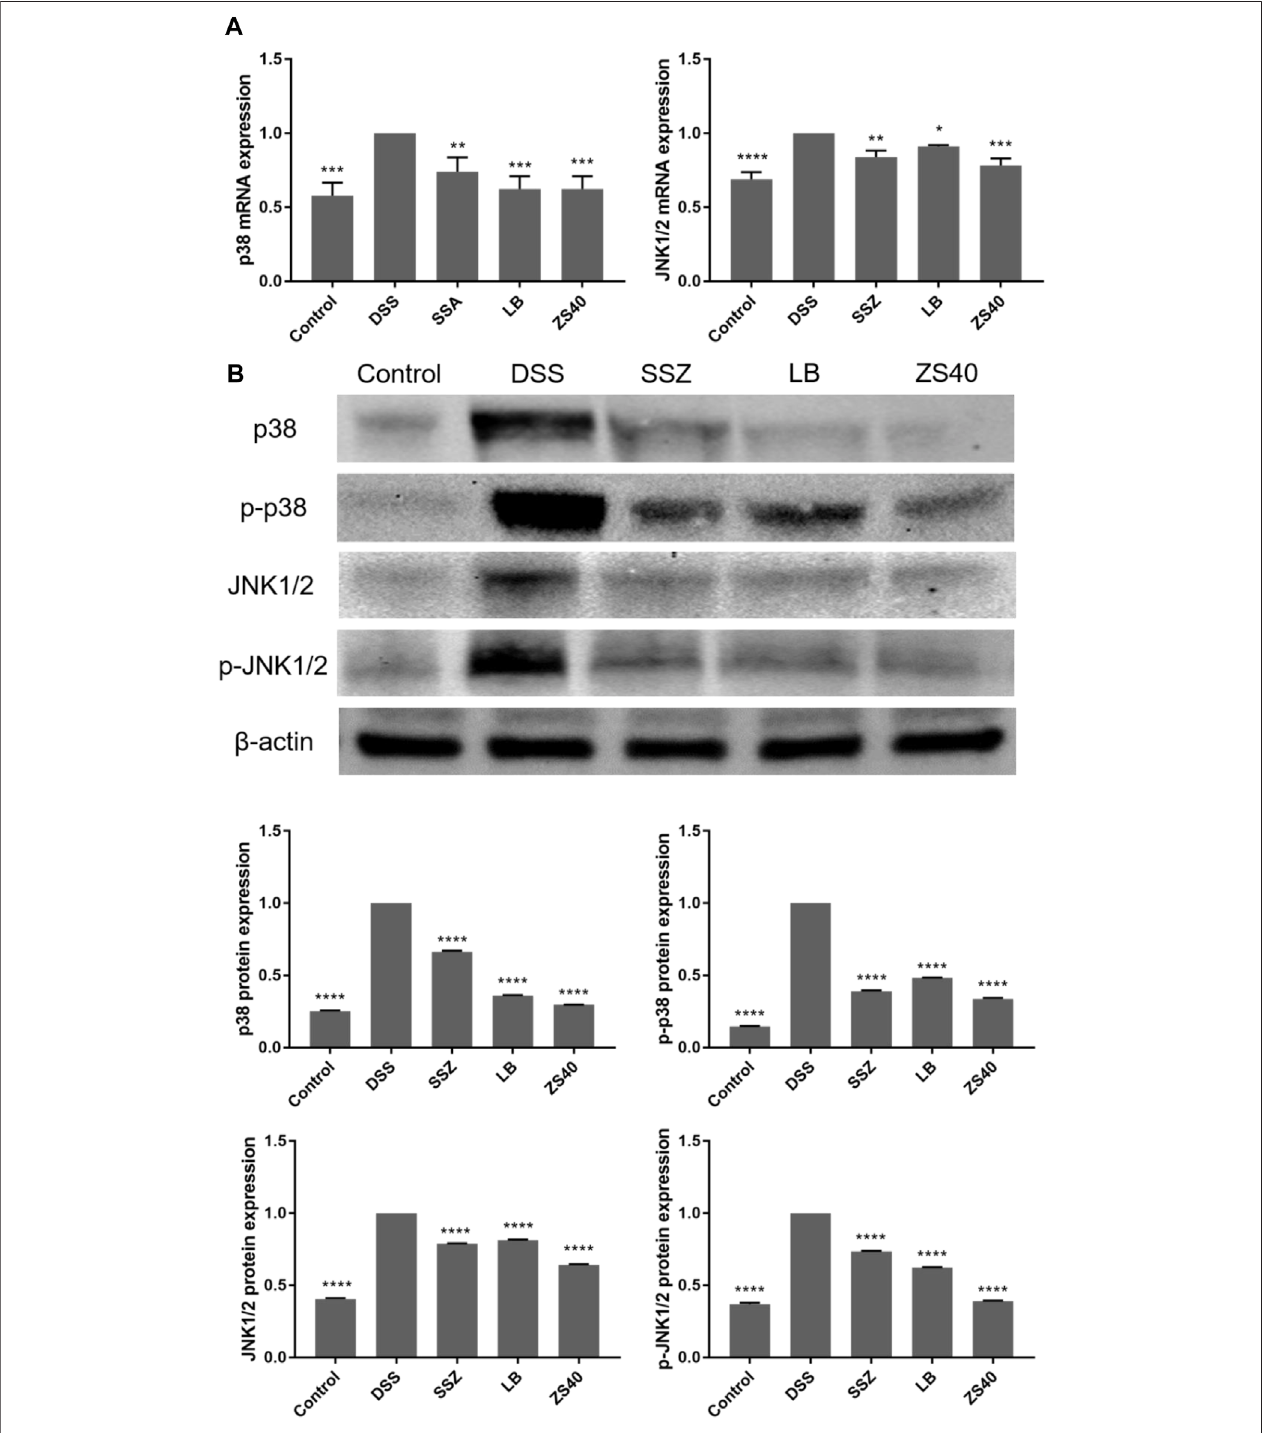
FIGURE 7 | The mRNA expression levels of p38 and JNK1/2 in colon of mice (A) . The protein expression levels of p38, p-p38, JNK1/2 and p-JNK1/2 in colon of mice (B) . Control group (cid:2) gavage with saline, DSS group (cid:2) 3% dextran sulfate sodium, SSZ group (cid:2) 500 mg/kg body weight (b.w.) salicylazosulfapyridine treatment dose, LBgroup (cid:2) 1.0 × 10 9 CFU/kg bodyweight (b.w.) L. bulgaricus treatmentdose, ZS40group (cid:2) 1.0 × 10 9 CFU/kg bodyweight (b.w.) L. fermentum ZS40treatment dose. Data are expressed as mean ± SD; * p < 0.05, ** p < 0.01, *** p < 0.001, **** p < 0.0001 compared with the DSS group.